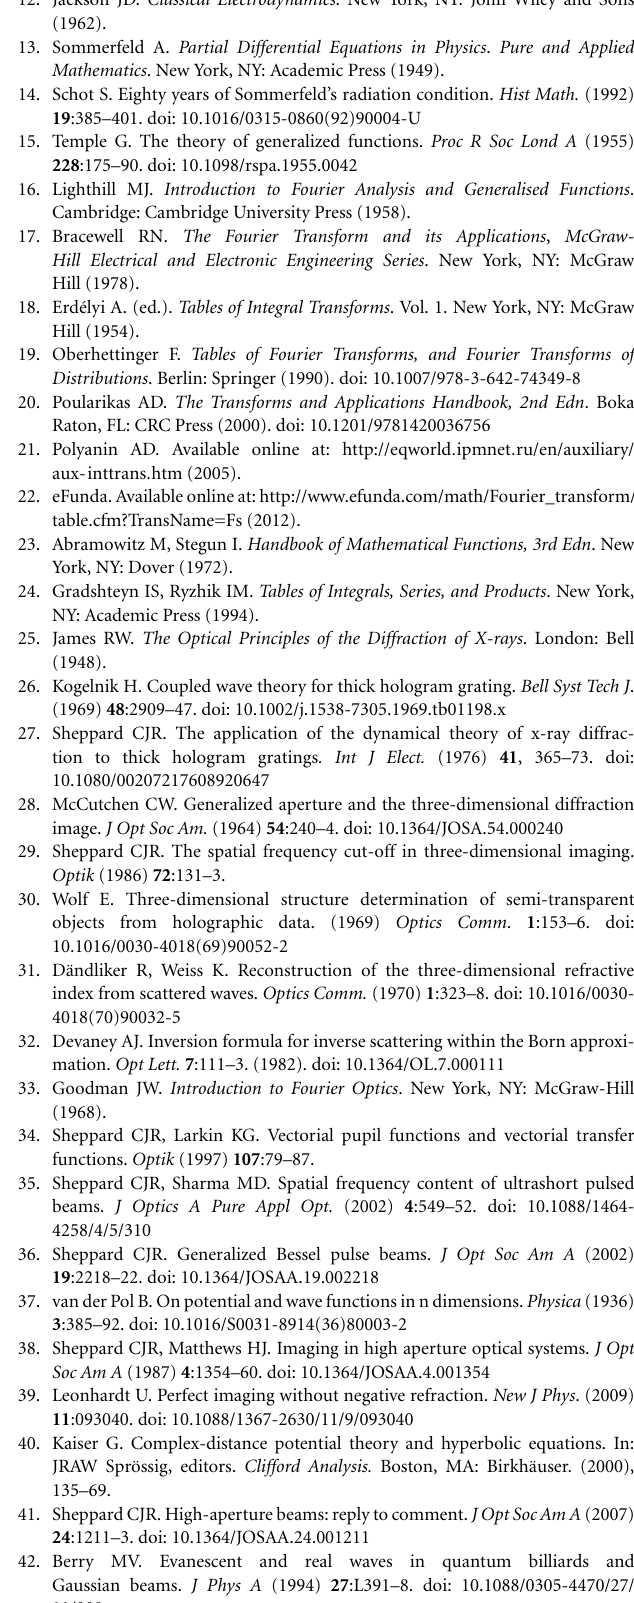
table.cfm?TransName=Fs (2012). 23. Abramowitz M, Stegun I. Handbook of Mathematical Functions, 3rd Edn . New York, NY: Dover (1972). 24. Gradshteyn IS, Ryzhik IM. Tables of Integrals, Series, and Products . New